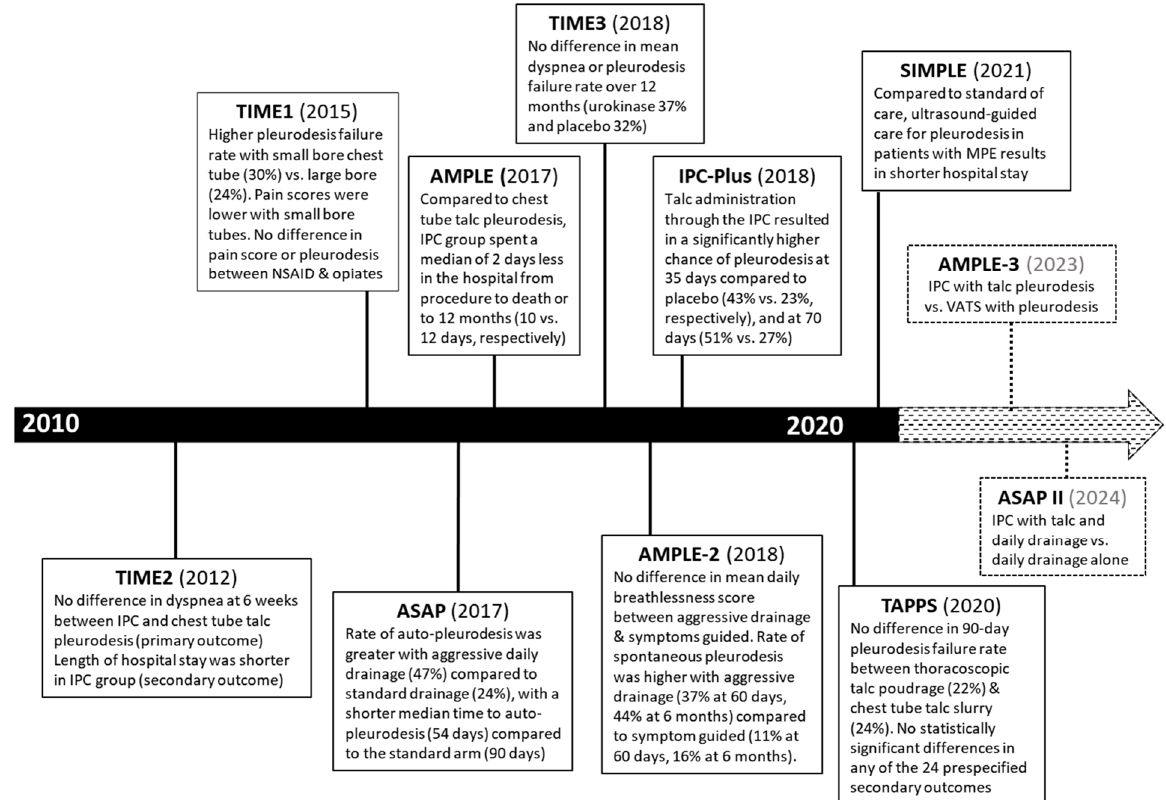
Figure 2. Key randomized controlled trials in MPE management over the last decade. NSAID (nonsteroidal anti-inflammatory drug), IPC (indwelling pleural catheter), MPE (malignant pleural effusion).